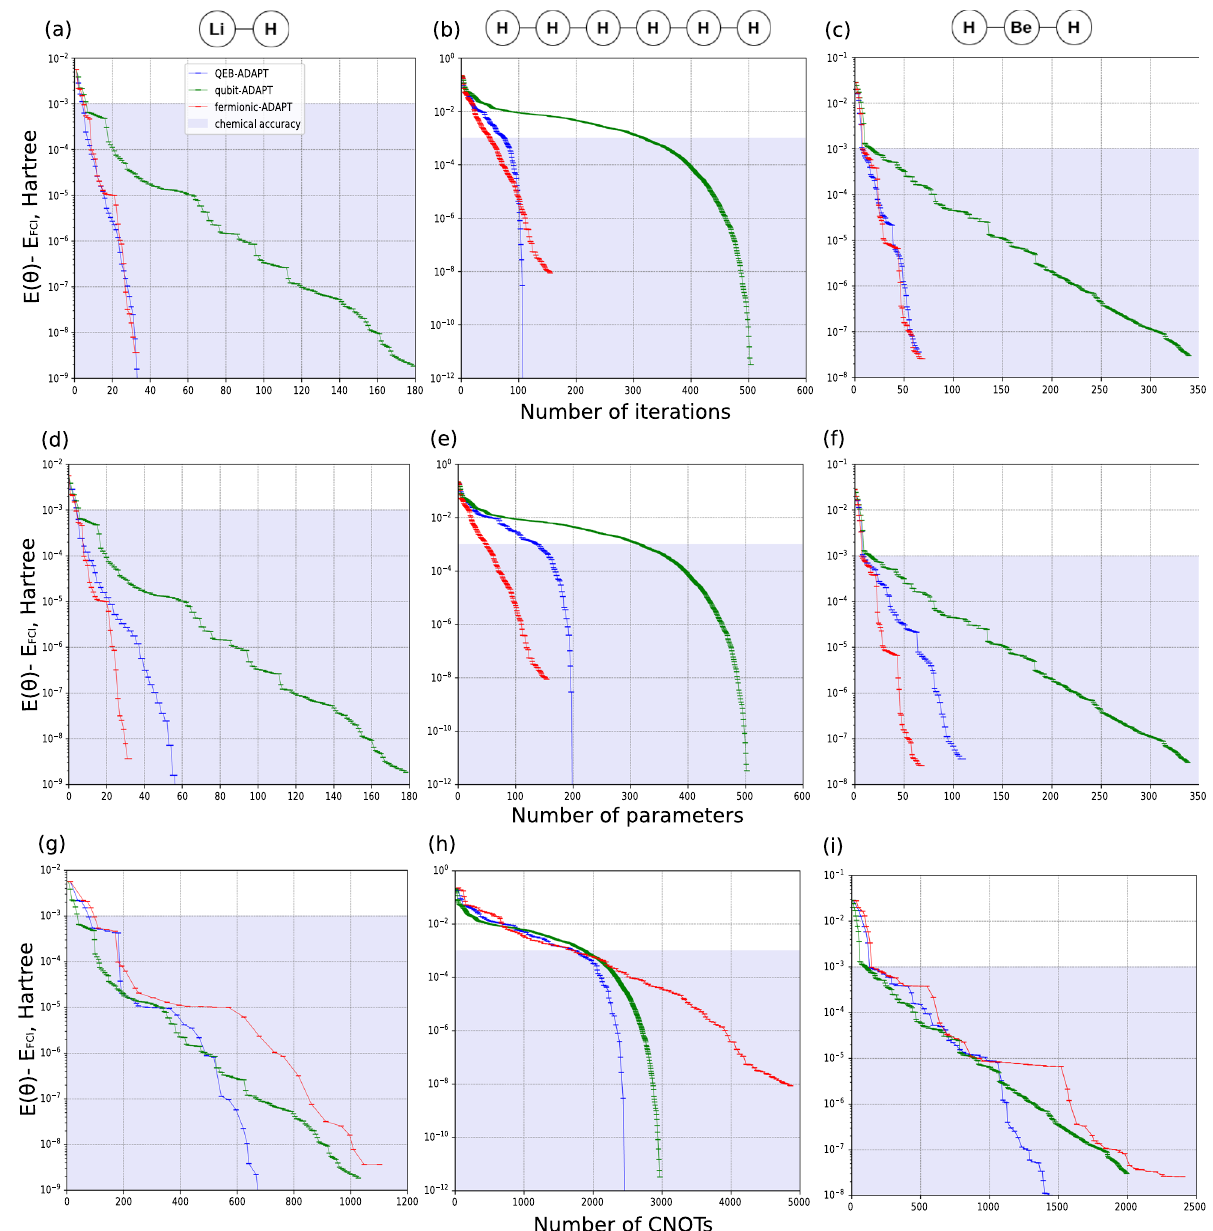
Fig. 6 Comparison of the QEB-ADAPT-VQE, the fermionic-ADAPT-VQE, and the qubit-ADAPT-VQE. The sub fi gures above present energy-convergence plots for the ground states of LiH, H 6 , and BeH 2 , in the STO-3G orbital basis set, at bond distances r Li-H = 1.546 Å , r H – H = 1.5 Å , and r Be – H = 1.316 Å . The plots compare the QEB-ADAPT-VQE (blue), the fermionic-ADAPT-VQE (red), and the qubit-ADAPT-VQE (green) protocols in terms of the number of iterations ( a – c ), the number of parameters ( d – f ), and the number of CNOT s ( g – i ). The QEB-ADAPT-VQE is performed for n = 1. All convergence plots are terminated for an energy-reduction threshold of ϵ = 10 − 12 Hartree. The CNOT counts in ( g – i ) are obtained assuming the use of the quantum circuits discussed in the section “ Ansatz at bond distances of around 1, 2, and 2.75 Å . The reason for these changes are molecular structure transformations, where different eigenstates of H become lowest in energy (energy-level crossings).